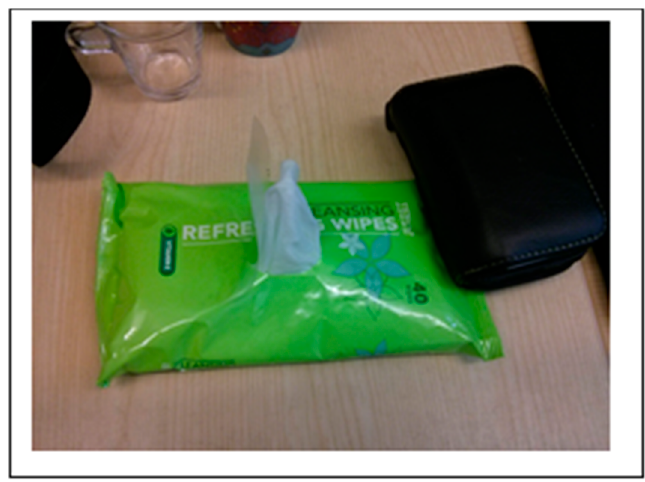
Figure 1. Photograph taken by Zaheem of wet wipes used to ‘wash’ before prayer.